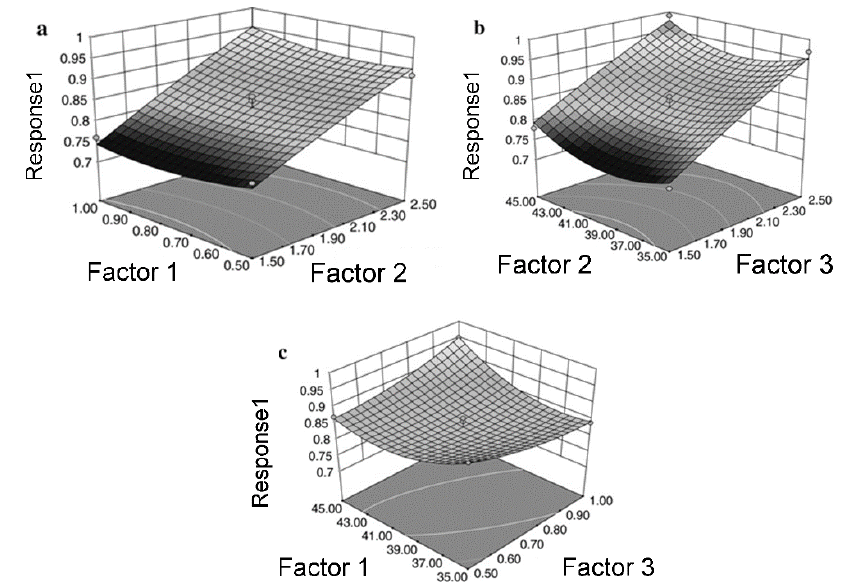
Figure 19. Example of response surface plots emphasizing the influence of independent variables (factors) interaction on the output variables (response).